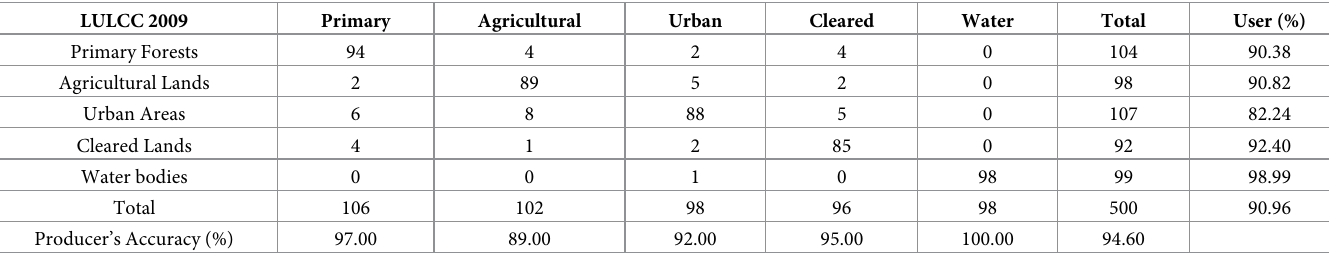
Table 4. Confusion matrix of 2009 land cover classification.